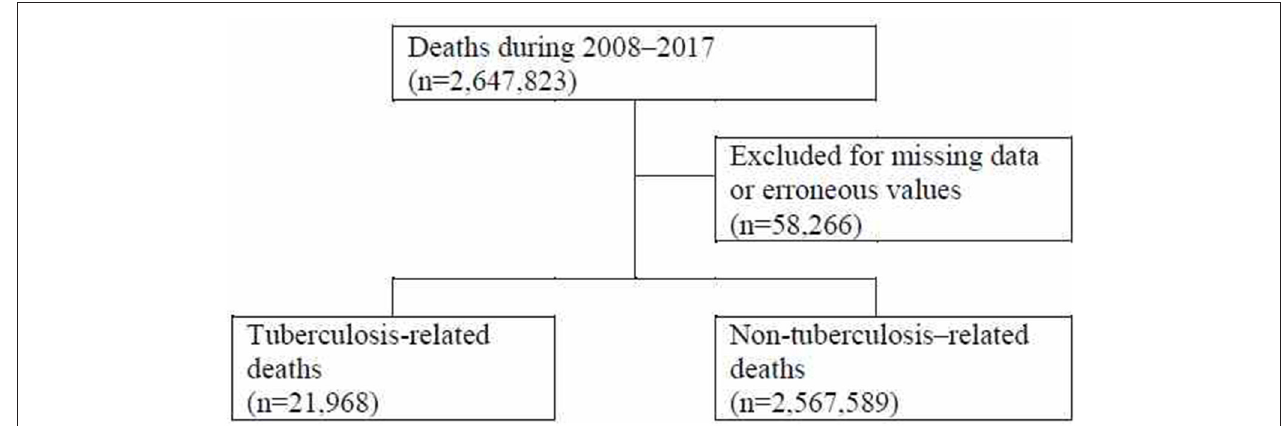
FIGURE 1 | Flowchart of the analysis set selection process.